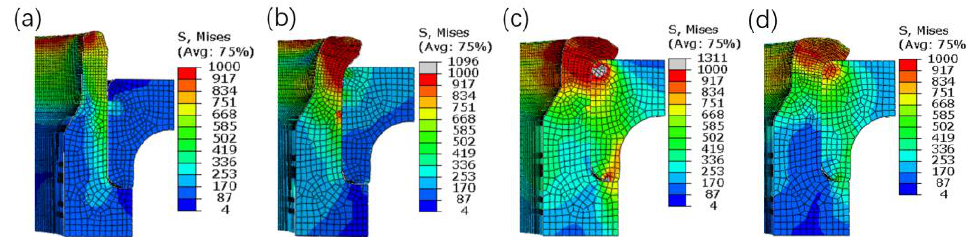
Figure 10. Equivalent stress contour plots at the representative moments. ( a ) 0.5 s. ( b ) 2.5 s. ( c ) 3.4 s. ( d ) 3.8 s.